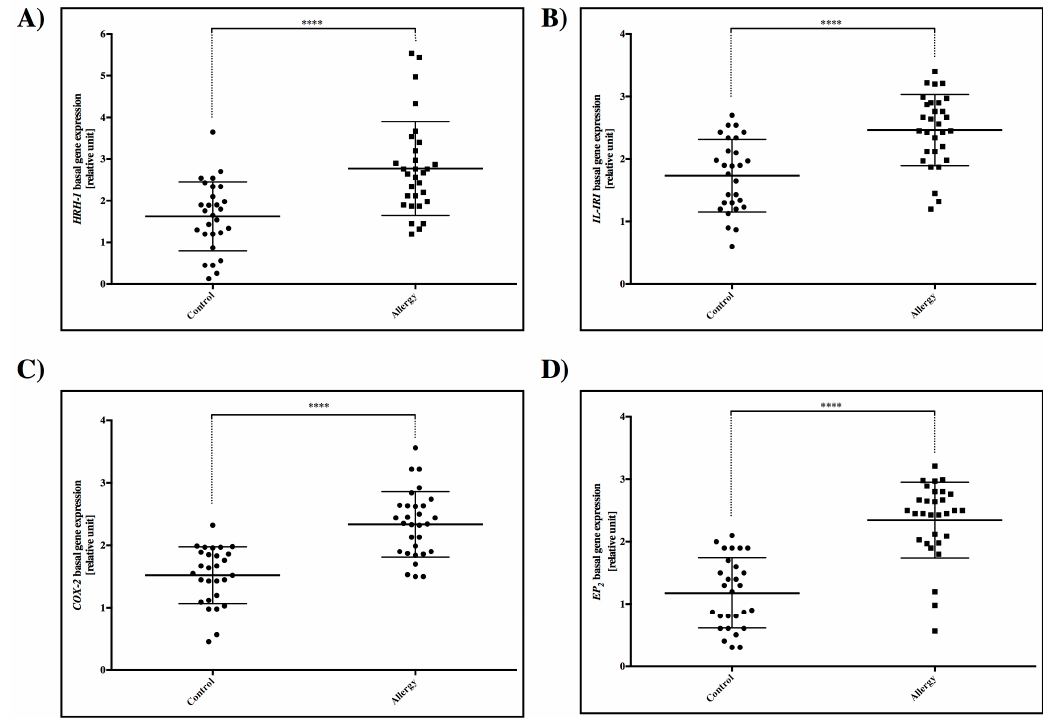
Figure 1. Basal gene mRNA expression of ( A ) HRH-1 receptor, ( B ) IL-1RI receptor, ( C ) COX-2, and ( D ) EP 2 receptor in cultured PBMC from the control and allergy groups. Statistically significant differences between the control and tested sample are directly above the error bar: **** p <